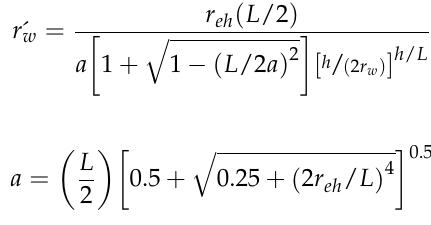
Figure 5. Basic schematics of a tight gas reservoir with bottom aquifer support.